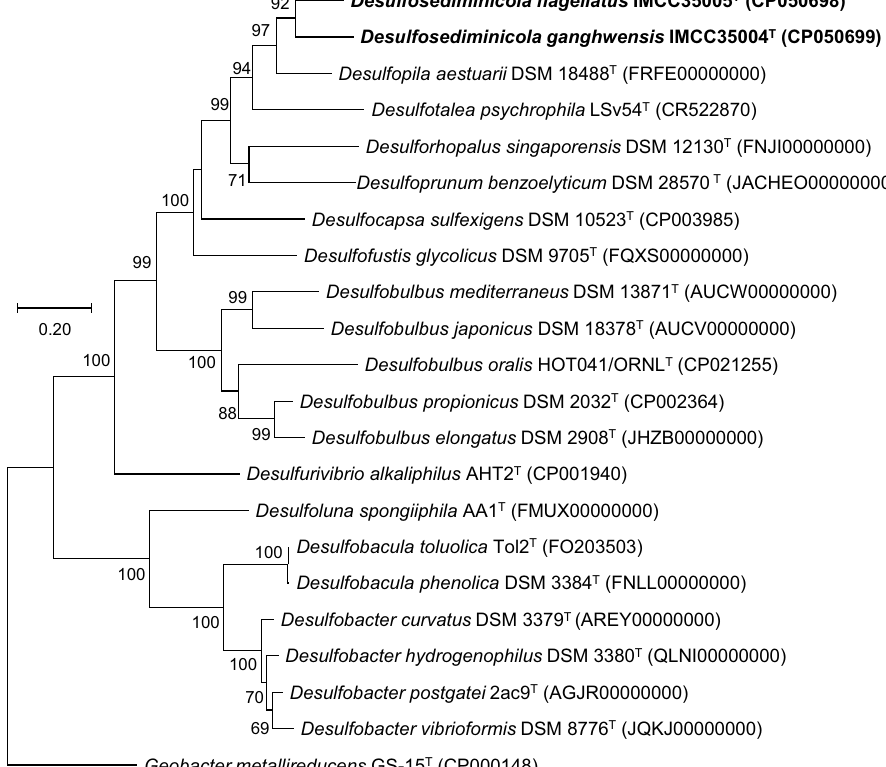
Figure 2. Positions of strains IMCC35004 T and IMCC35005 T on the phylogenetic tree based on the whole- genome sequences. A total of 29,457 amino acids were used for the phylogenomic analyses using up-to- date bacterial core gene sets (UBCG). The genome accession numbers are shown in parentheses. Geobacter metallireducens GS-15T (CP000148) was used as an outgroup. The bootstrap supports are shown at the nodes. The bar represents 0.2 substitutions per